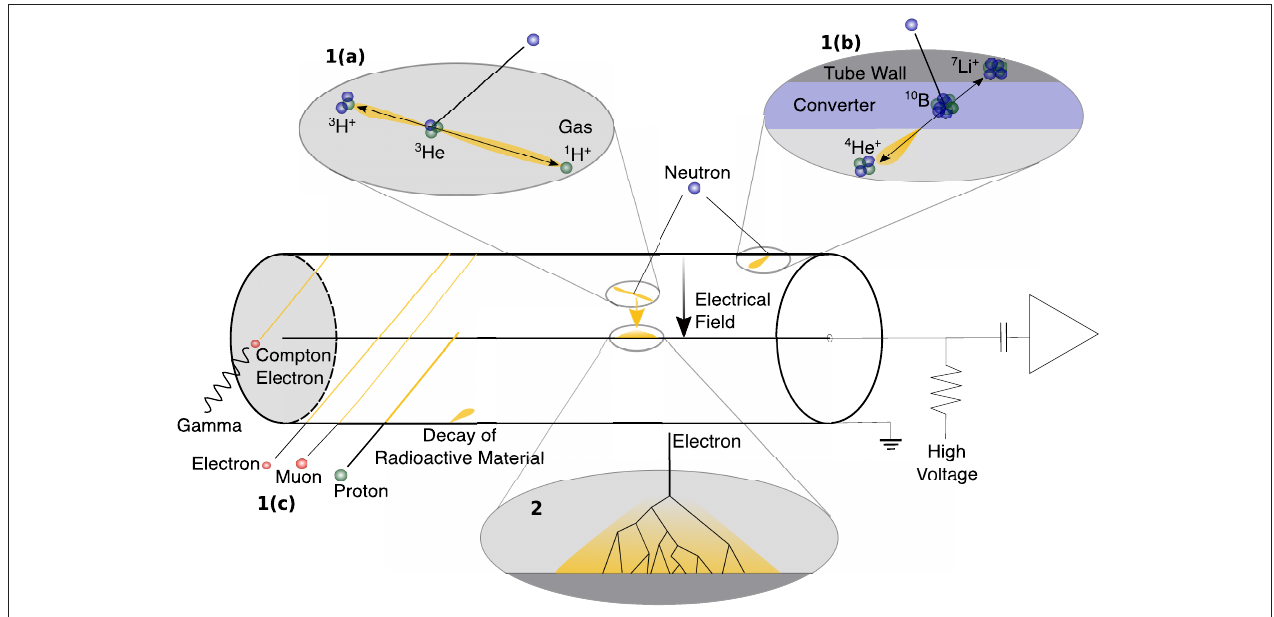
FIGURE 2 | Detection principle of a proportional counter. Neutron conversion into ionizing radiation takes place in either the gas phase (1a) or in solid material (1b). (1a) indicates the 3 He and (1b) the 10 B conversion processes. The fragments of the conversion process are emitted in opposite directions. The ionization trace is indicated in yellow. An electric field between the tube wall and the axial wire accelerates the generated electrons toward the wire. In the vicinity of the wire, the electron’s kinetic energy reaches the gas ionization energy and charge multiplication takes place (2). The resulting pulse is then read out by charge sensitive amplifiers. 1(c) Indicates other types of radiation that may induce a signal. The thickness of the tracks indicate the ionization energy deposition (see section 3.2.1).